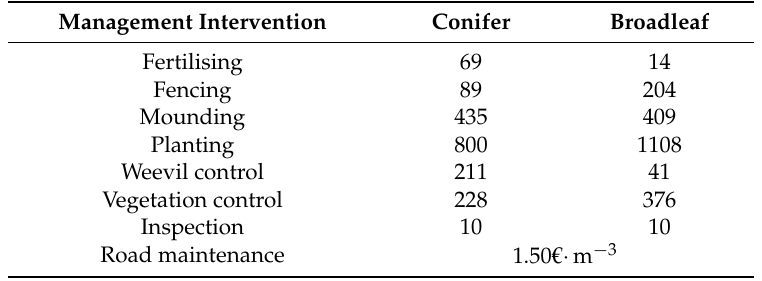
Table A1. Silvicultural costs ( € ¨ ha ´ 1 ) of various management activities. Source: Coillte.